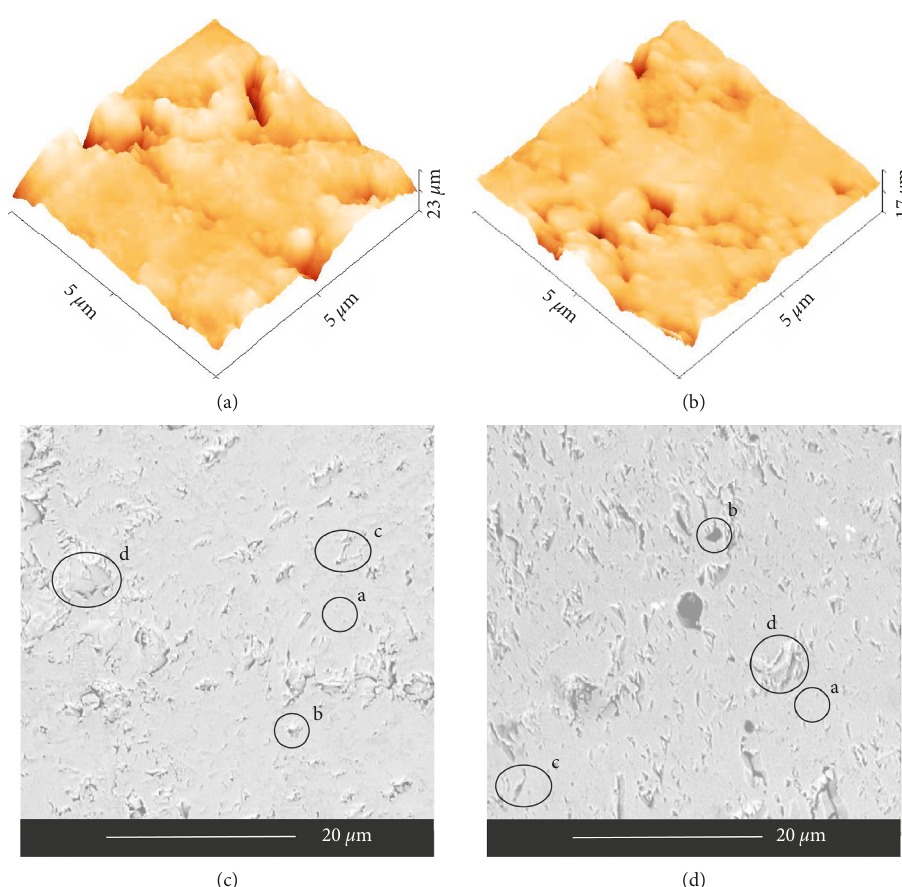
Figure 3: SEM and 3D AFM topographic images of discs prepared by incremental (right column) and one-step mixture (left column) methods. Fine close porosity (a), coarse close porosity (b), open porosity (c), and interparticle porosity